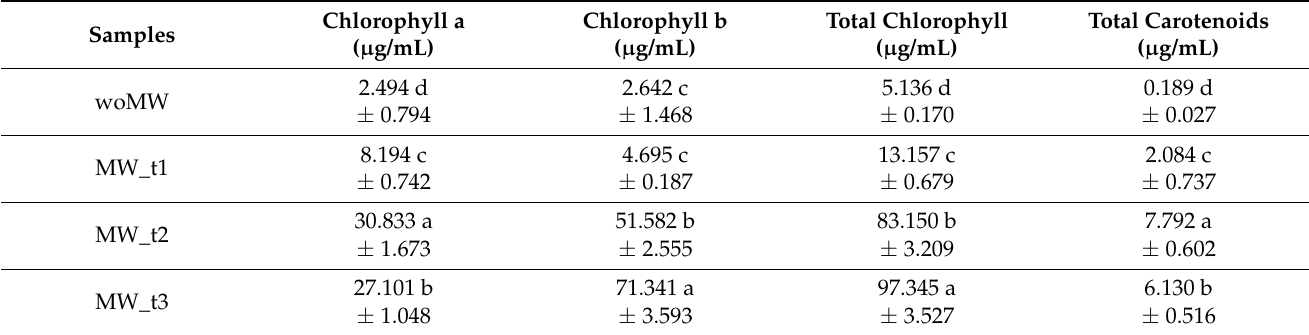
Table 3. Mean results of chlorophyll a, chlorophyll b, total chlorophyll, and total carotenoid content results from one-way ANOVA ( p = 0.05)